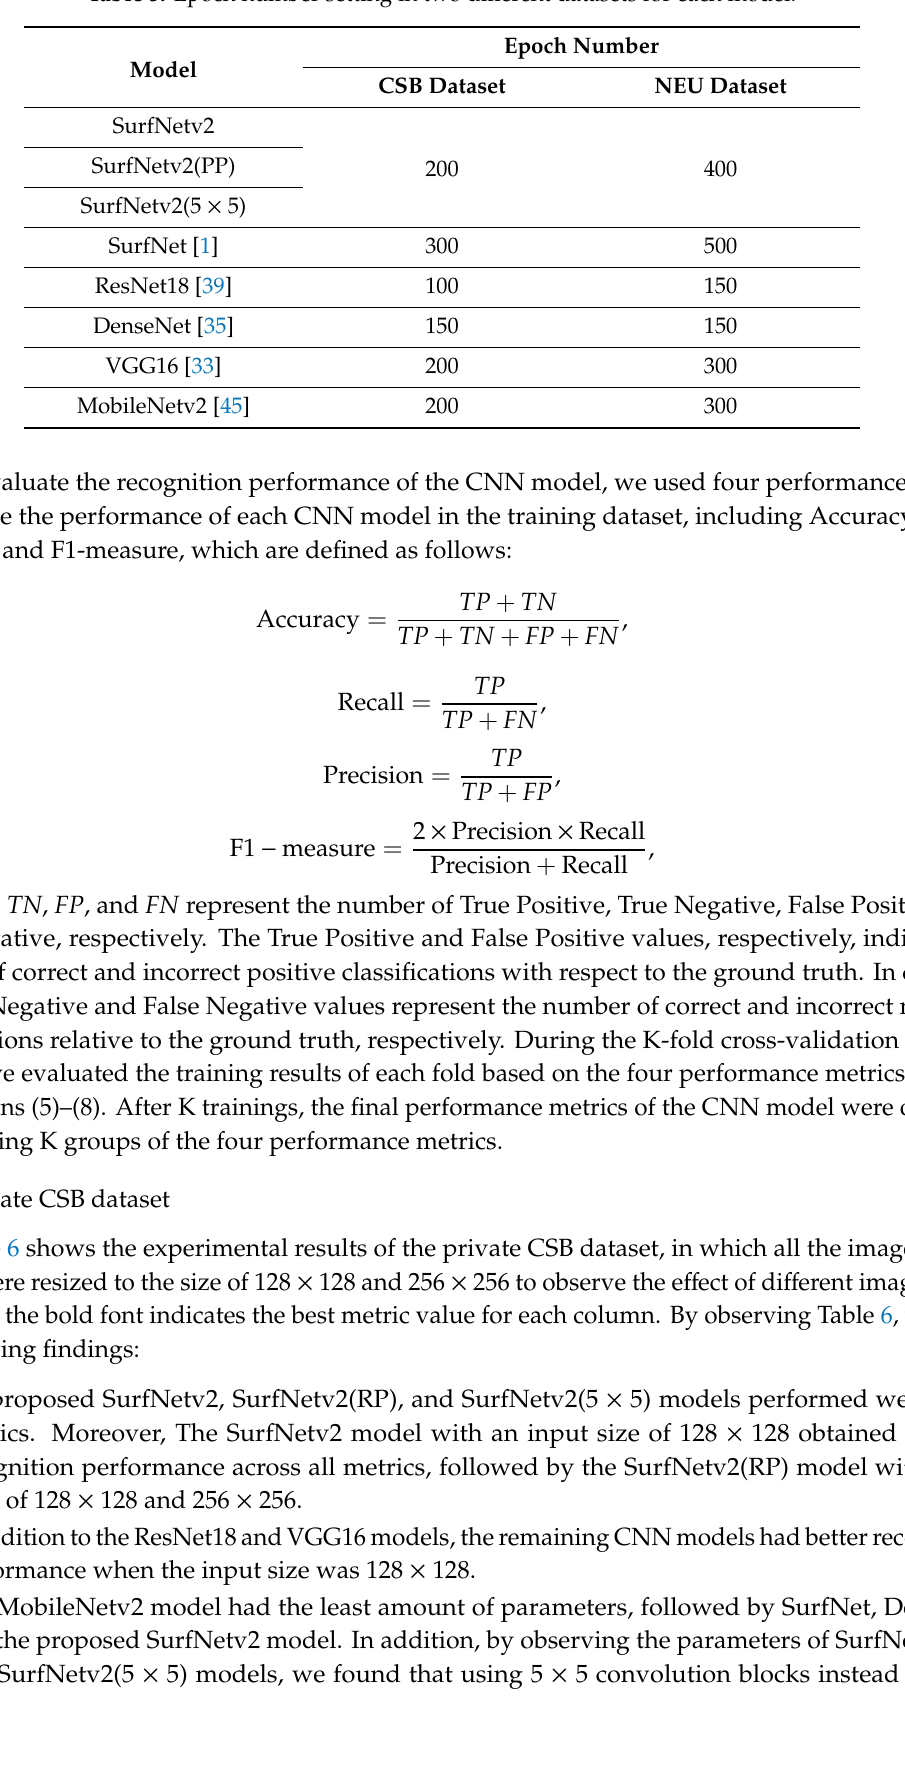
Table 5. Epoch number setting in two di ff erent datasets for each